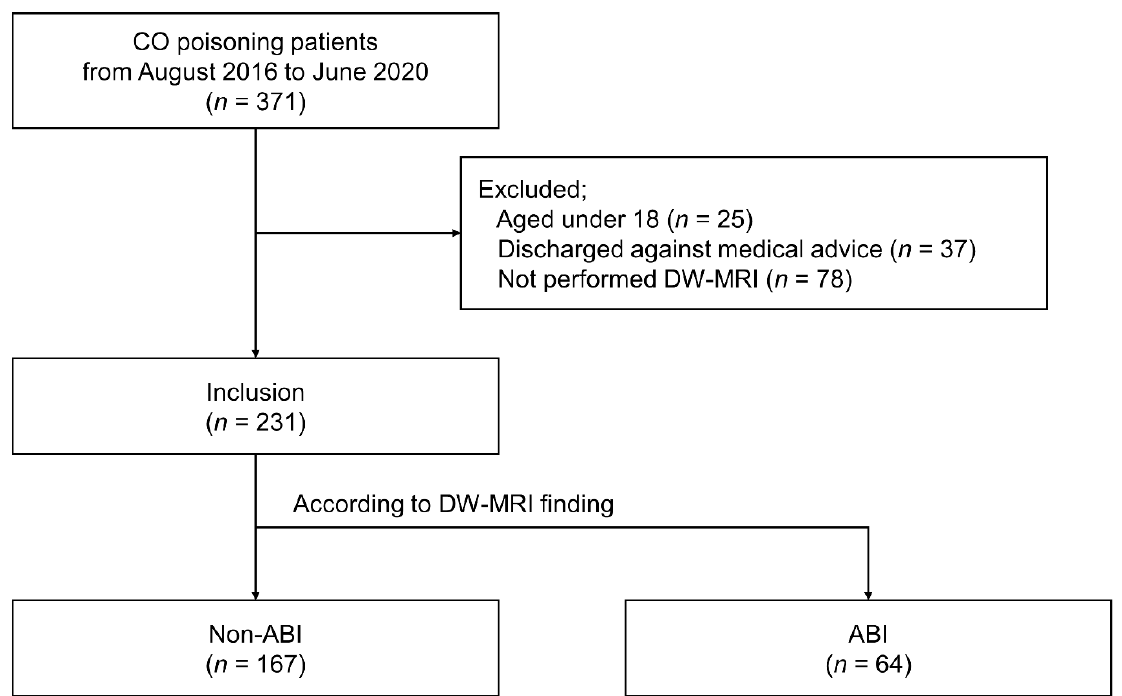
Figure 1. Flow diagram of the study procedures. ABI, acute brain injury; CO, carbon monoxide; DW-MRI, diffusion- weighted magnetic resonance imaging.